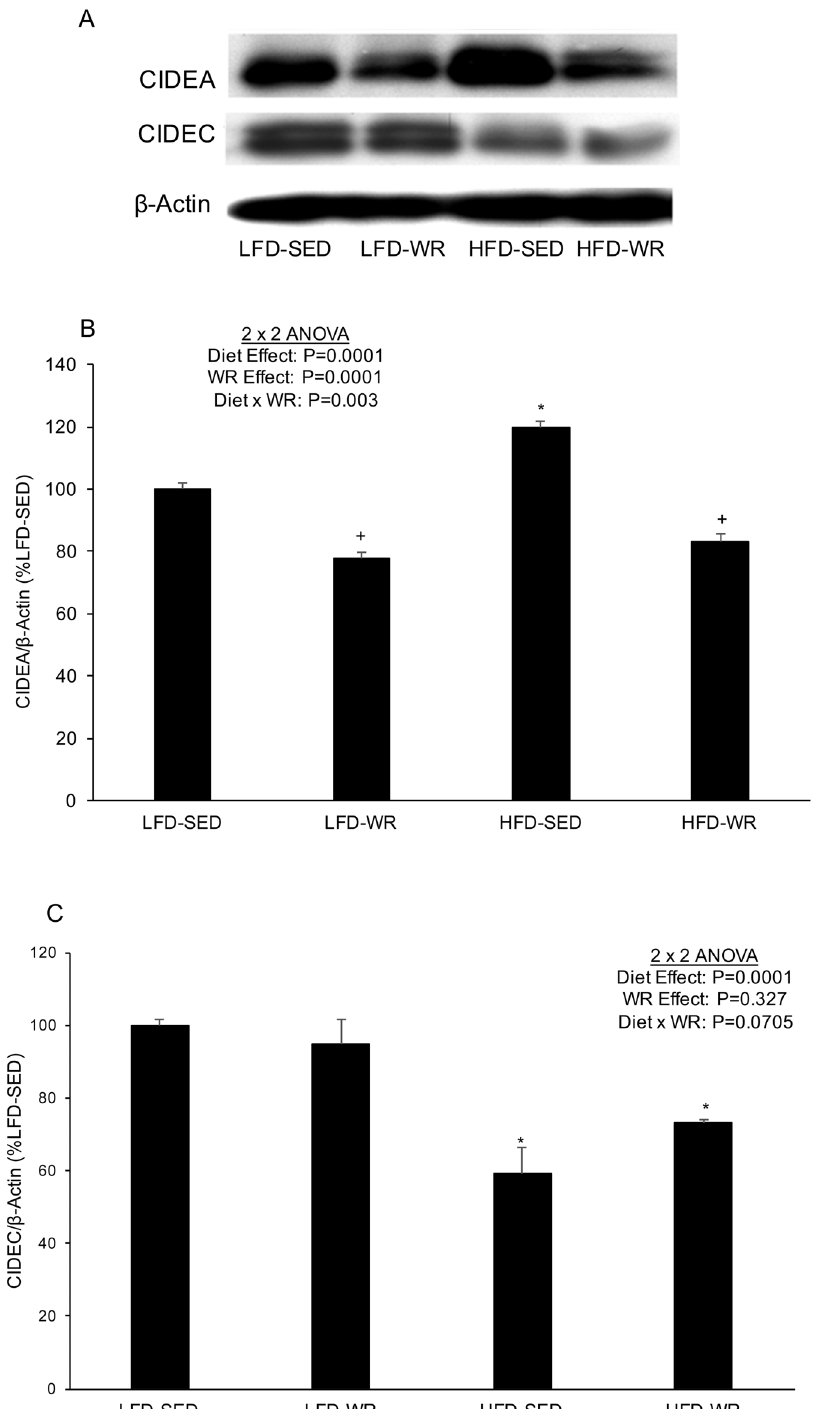
Fig 3. The effects of a high fat diet and voluntary wheel running on Cidea and Cidec protein expression in adipose tissue. Mice were fed a LFD or HFD and housed in standard cages or wheel running cages for weeks. Adipose tissue was excised and rapidly frozen in liquid nitrogen for subsequent Western blot analyses. (A) Representative immunoblots for Cidea and Cidec as well as β -actin as a loading control. Quantification of (B) Cidea and (C) Cidec protein, each normalized to β -actin. * , Denotes statistically significant difference from HFD-Vehicle. N = 5 mice per group.